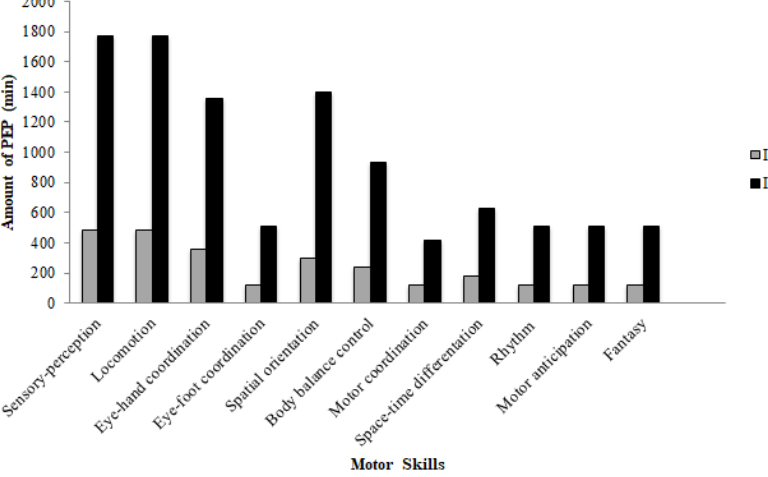
Figure 1. Number of hours spent for the development of the motor skills in I1 and I2 groups. 2.2. Intervention